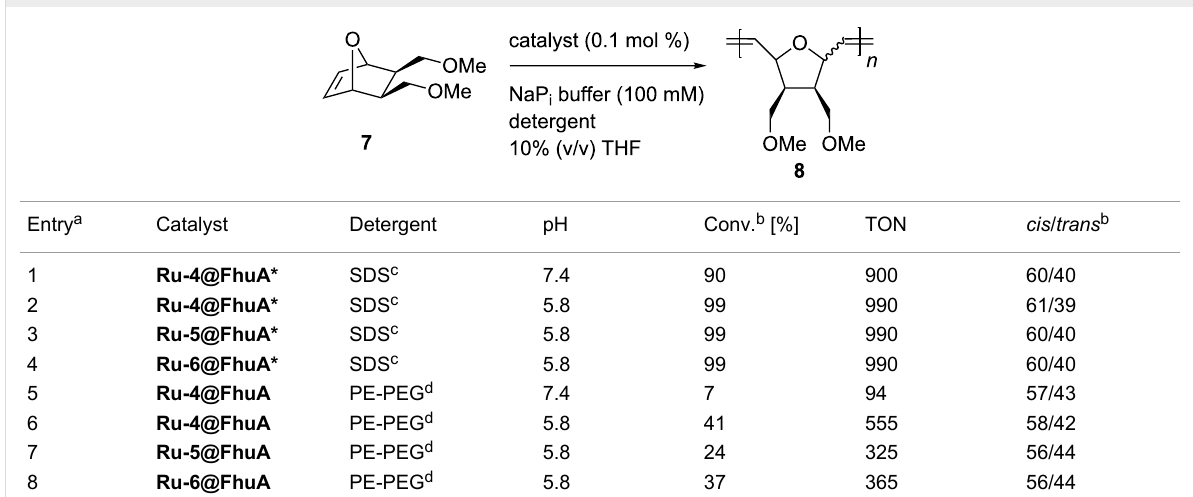
Table 2: ROMP of substrate 7 catalyzed by Ru-4/5/6@FhuA